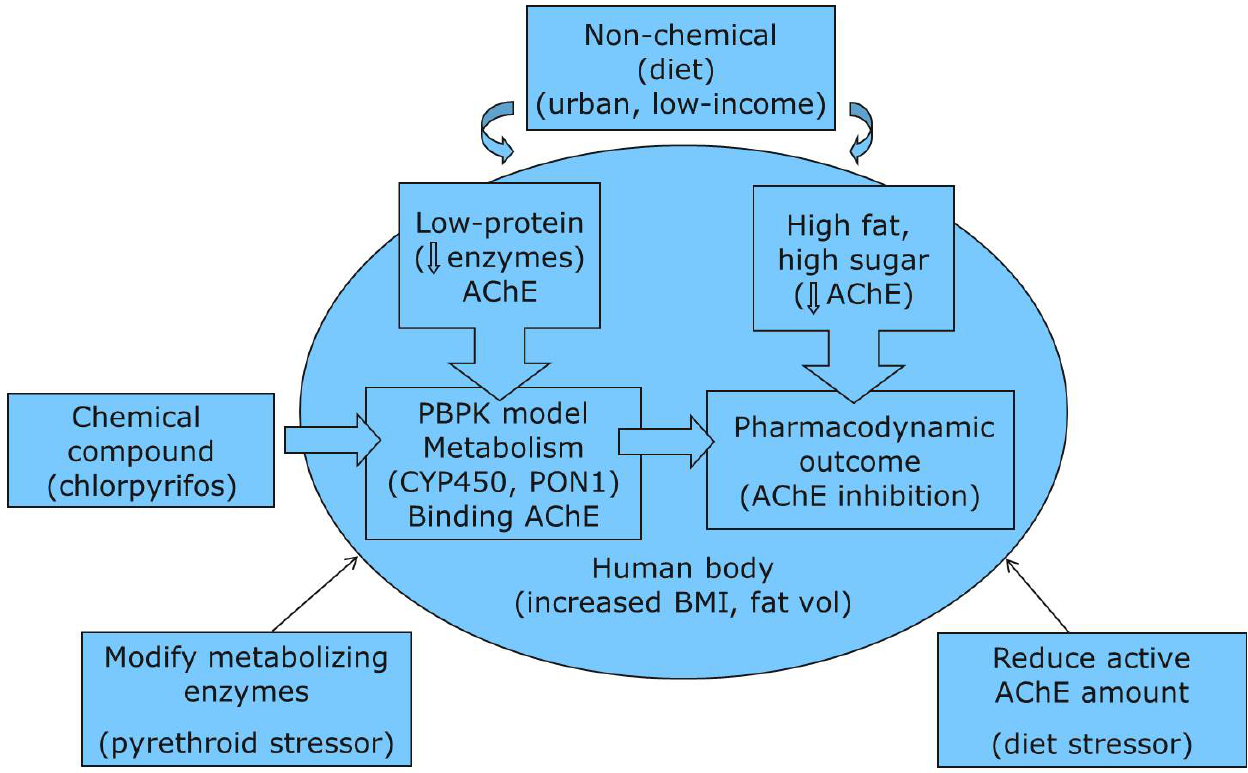
Figure 1. Diagram of risk framework using PBPK/PD model application for OPs with chemical and non-chemical stressors (Parentheses depict specifics for this